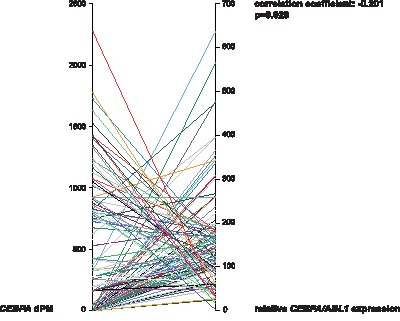

CEBPA expression correlates with promoter methylation levels.Spearman’s rank correlation of CEBPA expression levels to CEBPA methylation levels shows a significant inverse correlation (Spearman correlation coefficient = -0,201, p = 0.023).